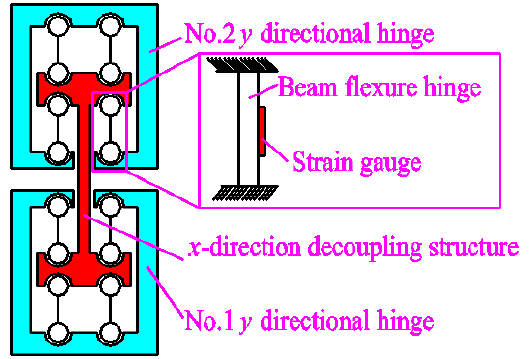
Figure 8. The y -guidance element principle.